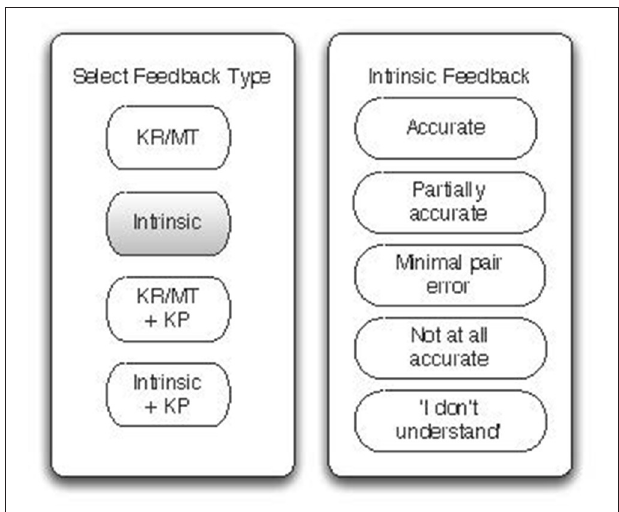
FIGURE 2 | The Main menu screen and the Intrinsic feedback menu screen seen by the “Wizard”.